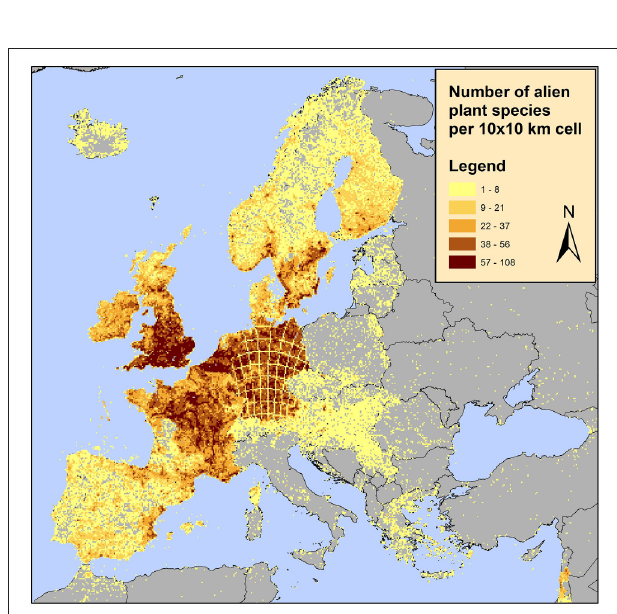
FIGURE 5 | Distribution of alien plants in Europe on a 10 10 km 2 grid × according to the available data in the European Alien Species Information Network (EASIN; Katsanevakis et al., 2015). These spatial data, integrated in EASIN, originate from the following sources: (1) the Global Biodiversity Information Facility (GBIF; http://www.gbif.org/); (2) the Global Invasive Species Information Network (GISIN; http://www.gisin.org); (3) the Regional Euro-Asian Biological Invasions Centre (REABIC; http://www.reabic.net/); (4) the European and Mediterranean Plant Protection Organization (EPPO; http://www.eppo.int/); (5) the Norwegian Biodiversity Information Centre (NBIC, http://www.biodiversity.no/) and (6) EASIN-Lit (http://easin.jrc.ec. europa.eu/About/EASIN-Lit; Trombetti et al., 2013).